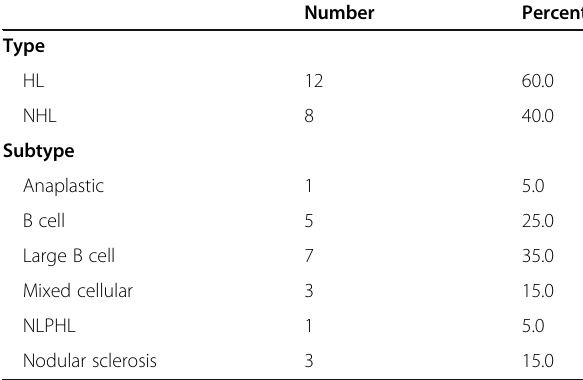
Table 4 Lymphoma subtypes of the enrolled study group